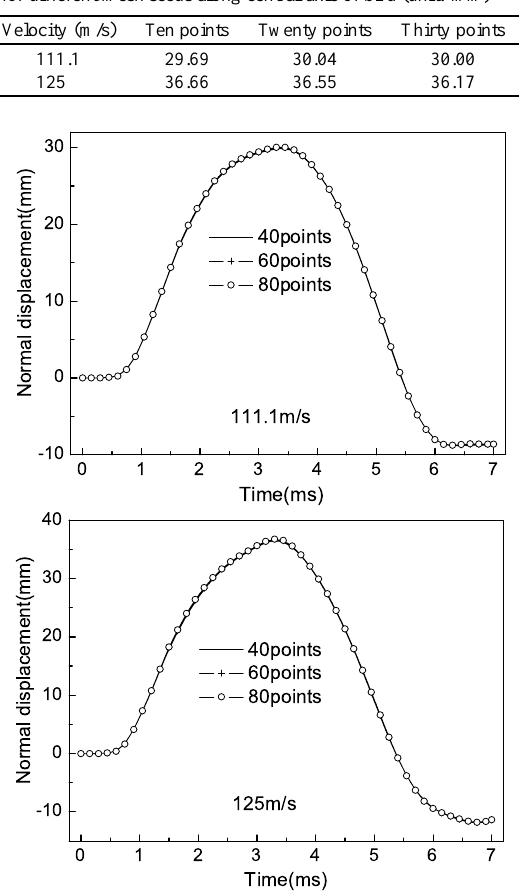
Fig. 12. Time history of normal displacement at the center on inner surface for different mesh seeds along camber line of windshield. normal displacement at the center on inner surface is given in Table 6. It can be seen that mesh seeds along central axis of bird influences little on the maximal normal displacement at the center on inner